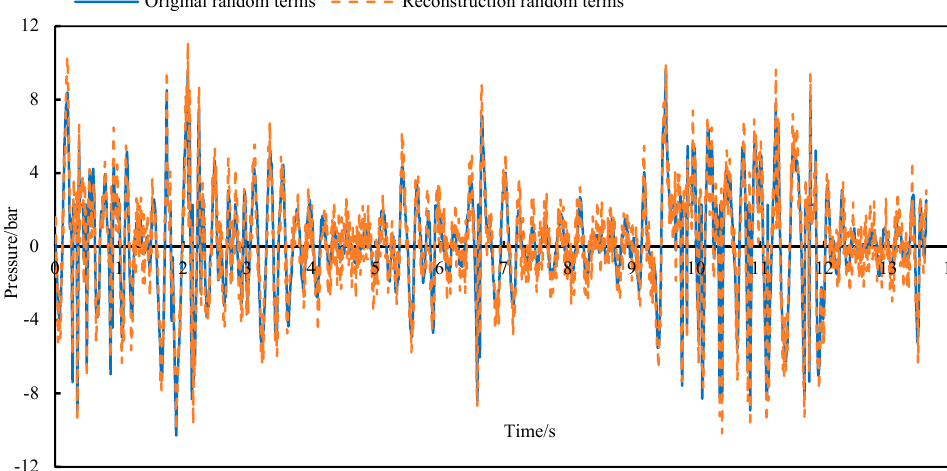
Figure 16. The comparison result between the reconstructed and original load random term.